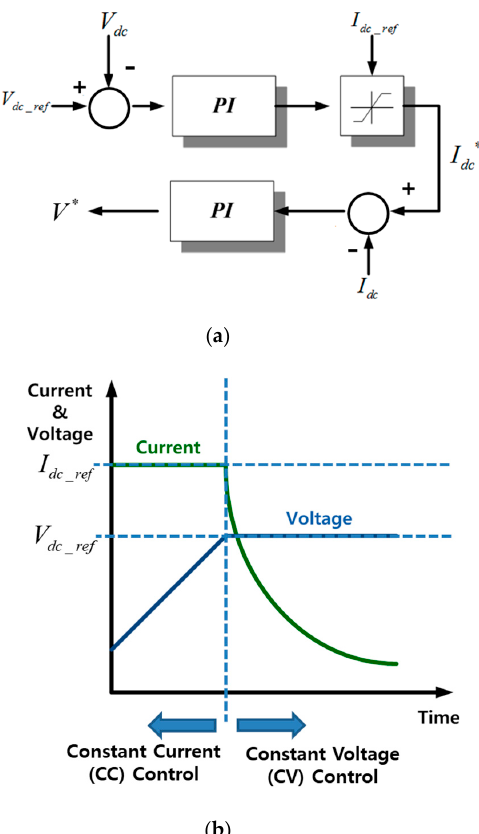
Figure 7. Constant current (CC) and constant voltage (CV) controls: ( a ) General CC-CV controller block diagram; ( b ) CC-CV control operation.